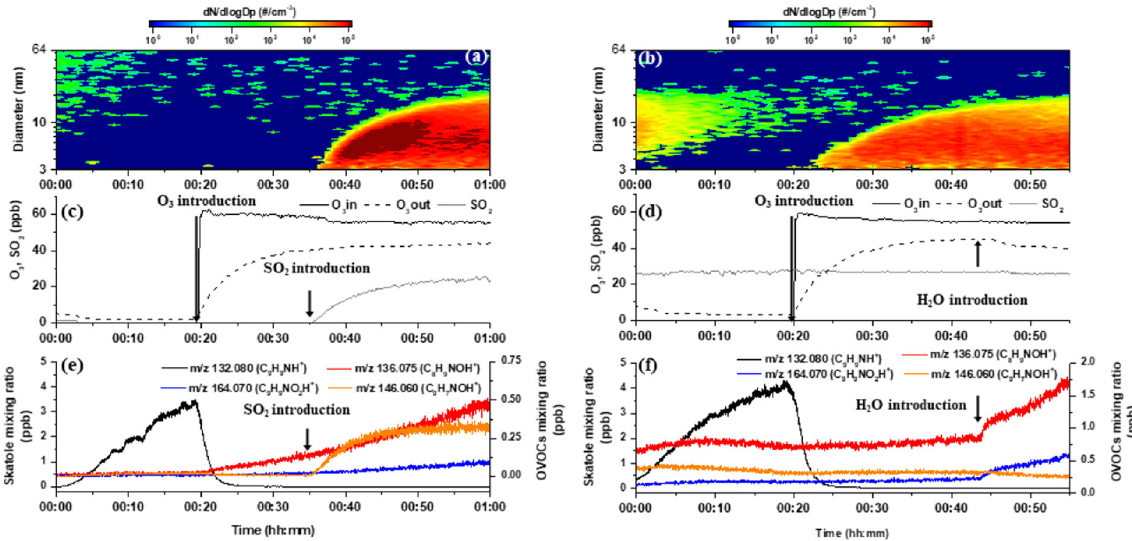
Fig. 4 Skatole ozonolysis experiment. a , b Temporal evolution of the particle number concentration and size distribution. c , d Temporal evolution of O 3 entering the chamber (black line), O 3 measured at the exit of the chamber (black dotted line) and SO 2 (gray line). e , f Temporal evolution of m/z 132.080 C 9 H 9 NH + (black line, left axis), m/z 136.075 C 8 H 9 NOH + (red line, right axis), m/z 146.060 C 9 H 7 NOH + (orange line, right axis), and m/z 164.070 C 9 H 9 NO 2 H + (blue line, right axis). Left column: SO 2 introduction at 00:35 min; right column: H 2 O introduction at 00:43